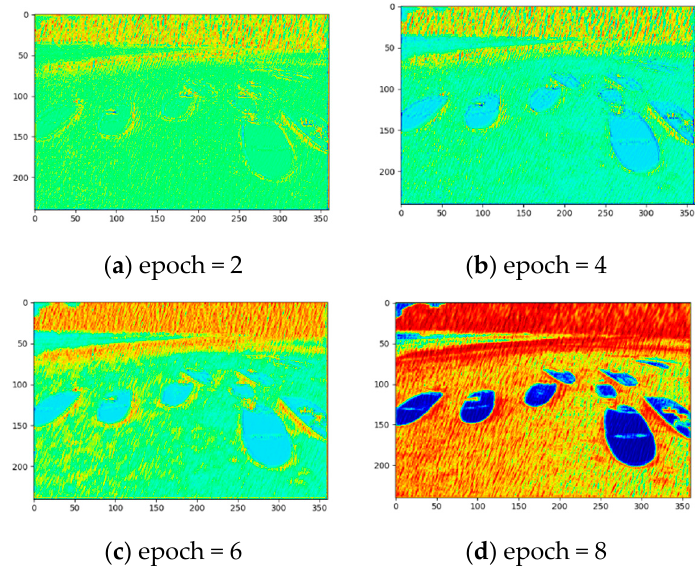
Figure 3. Visualization of the recurrent neural network learning process.